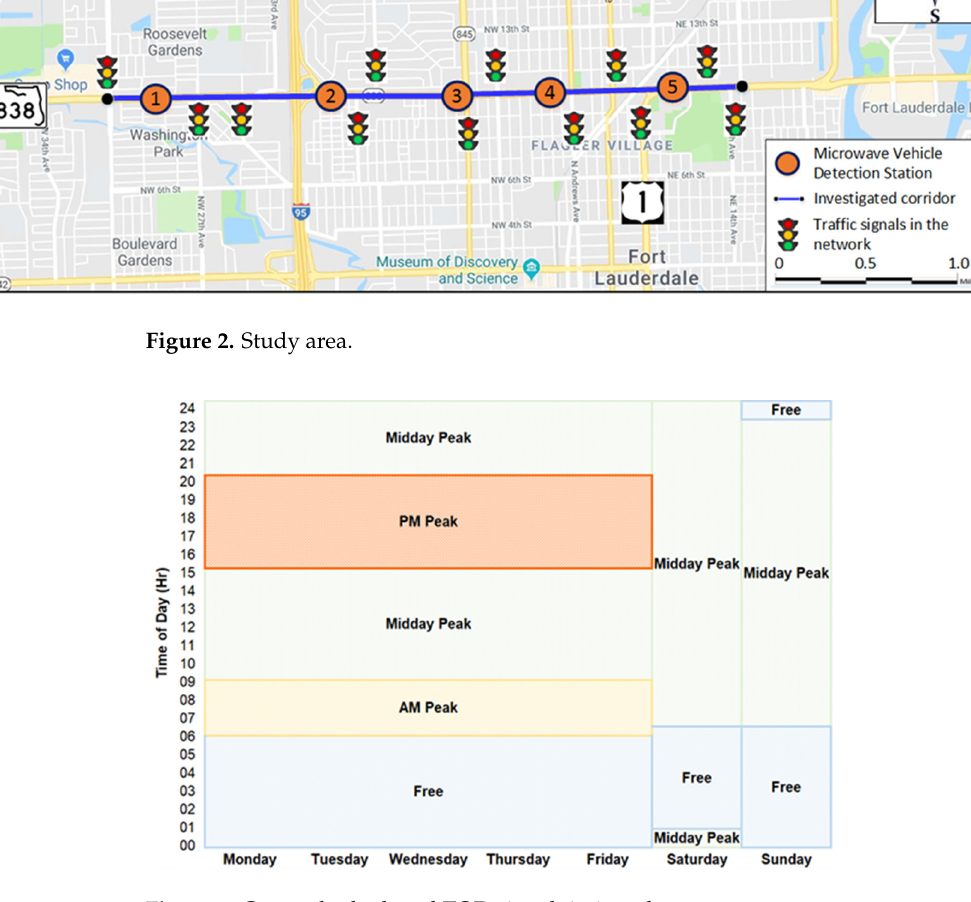
Figure 2. Study area.